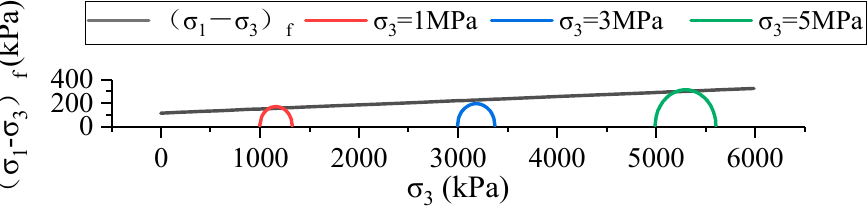
Figure 7. Sediment strength envelope diagram.